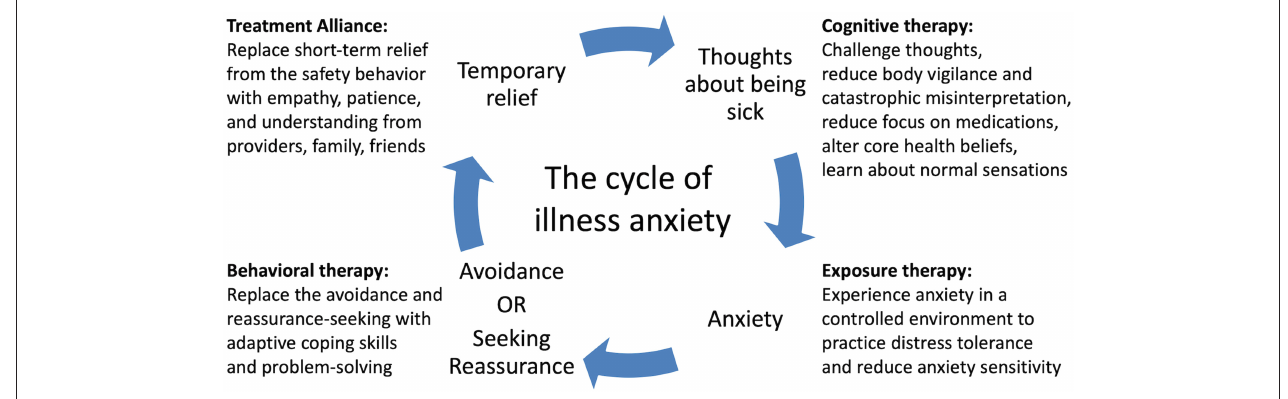
FIGURE 1 | A cognitive-behavioral model of illness anxiety. A feedback loop of thoughts of being sick and safety behaviors (avoidance or reassurance-seeking) causes worsening of illness anxiety over time. Cognitive, exposure, and behavioral therapies as well as strong therapeutic alliance can break the cycle and improve